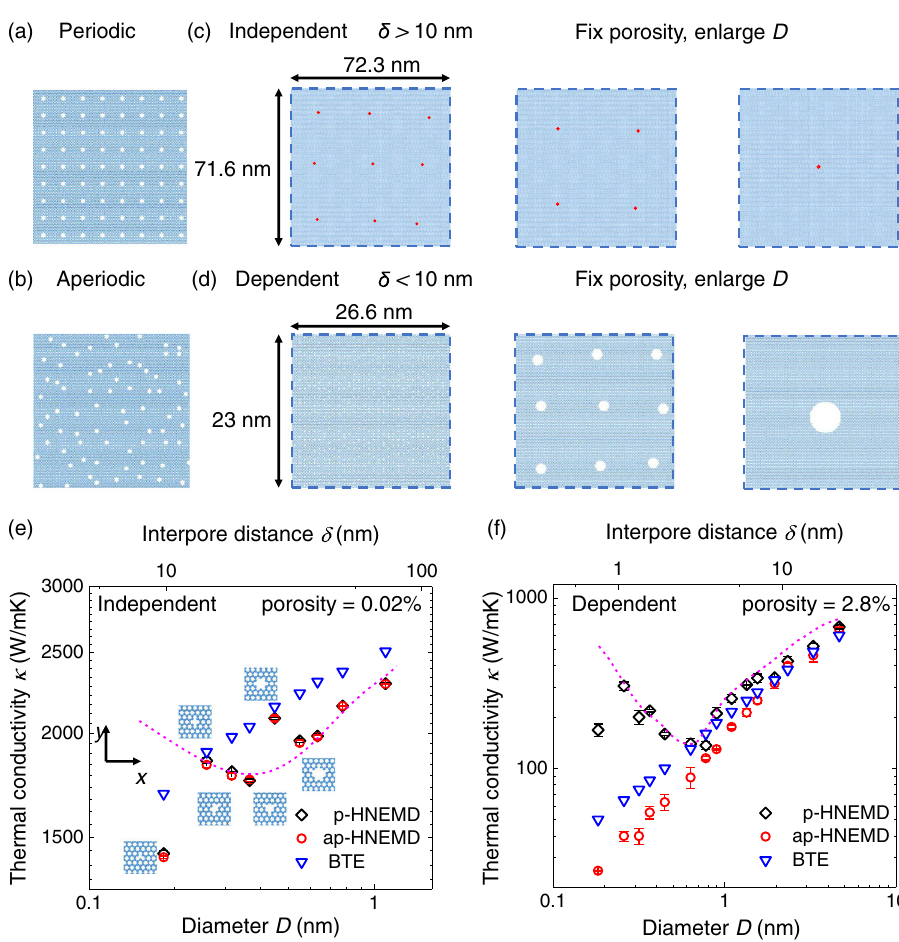
Fig. 4 Impact of pore size on the thermal conductivity of porous graphene in the independent and dependent scattering regimes. a The schematic of periodic porous graphene. b The schematic of aperiodic porous graphene. The aperiodic con fi guration is generated by randomly shifting the centers of pores from their periodic positions. c The simulation setup for the independent scattering regime. The simulation domain is set as 72.3 nm × 71.6 nm and the porosity is fi xed as 0.02%. The interpore distance is always larger than 10 nm, ensuring independent scattering. Periodic boundary conditions are applied to the boundaries of the domain (denoted by the dash line). d The simulation setup for the dependent scattering regime. The simulation domain is set as 26.6 nm × 23 nm and the porosity is fi xed at 2.8%. The interpore distance is always smaller than 10 nm, ensuring dependent scattering. Periodic boundary conditions are applied to the boundaries of the domain (denoted by the dash line). e Thermal conductivities of periodic and aperiodic porous graphene of different pore sizes computed by HNEMD and phonon BTE in the independent scattering regime. f Thermal conductivities of periodic and aperiodic porous graphene of different pore sizes computed by HNEMD and phonon BTE in the dependent scattering regime. The interpore distances δ are shown at the top of the fi gures. The error bar denotes the